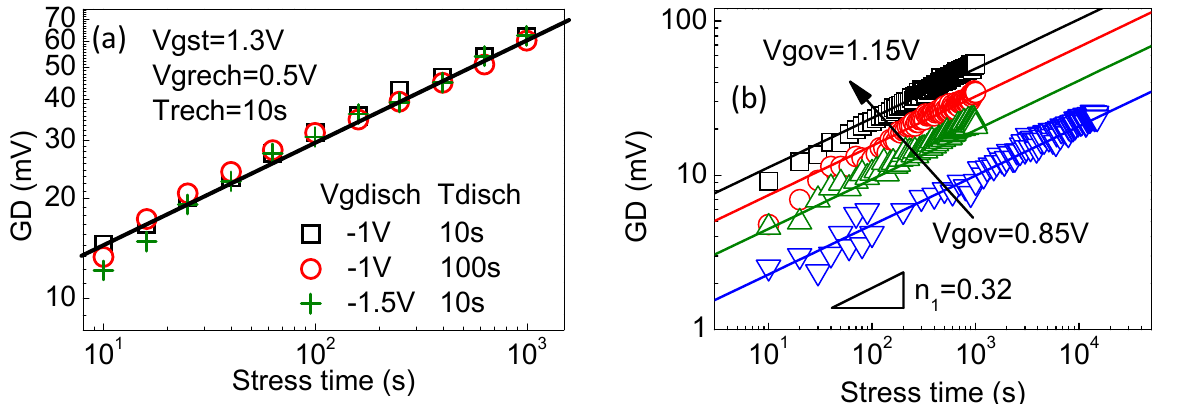
Figure 49. ( a ) The generated defects measured by the SDR technique were independent of the measurement conditions. ( b ) The GD kinetics under different stress Vgov. The power exponents were insensitive to Vgov [39].